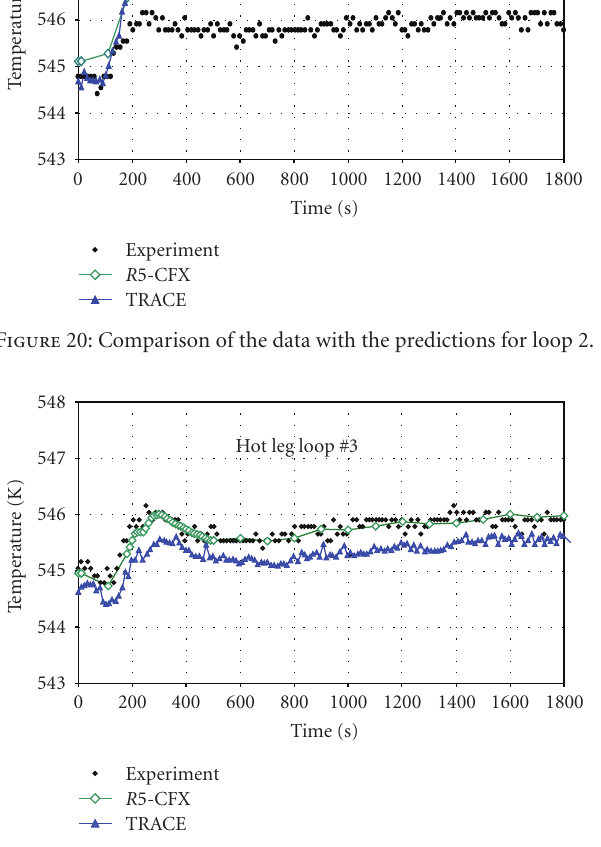
Figure 21: Comparison of the data with the predictions for loop